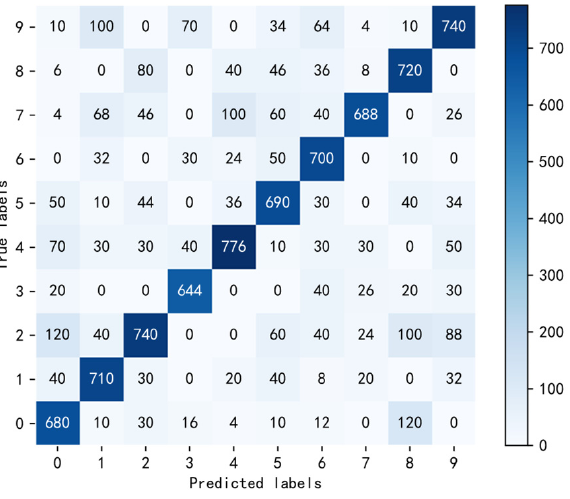
Figure 8. Classification result of samples with μ = 2.2.